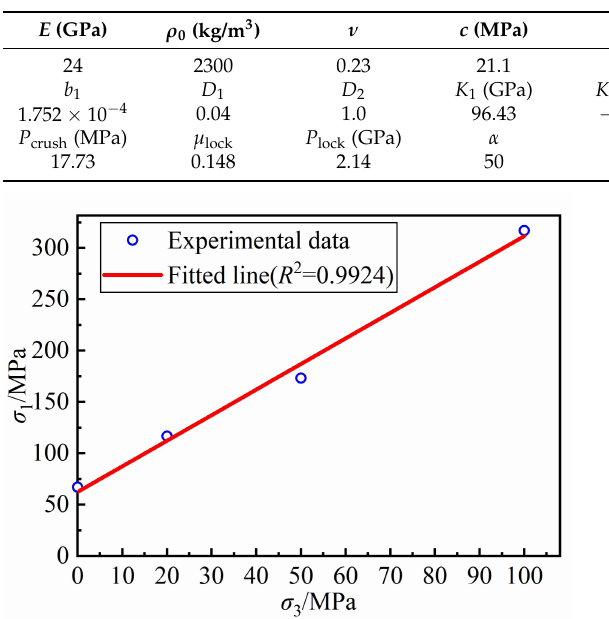
Table 1. The parameters of limestone.